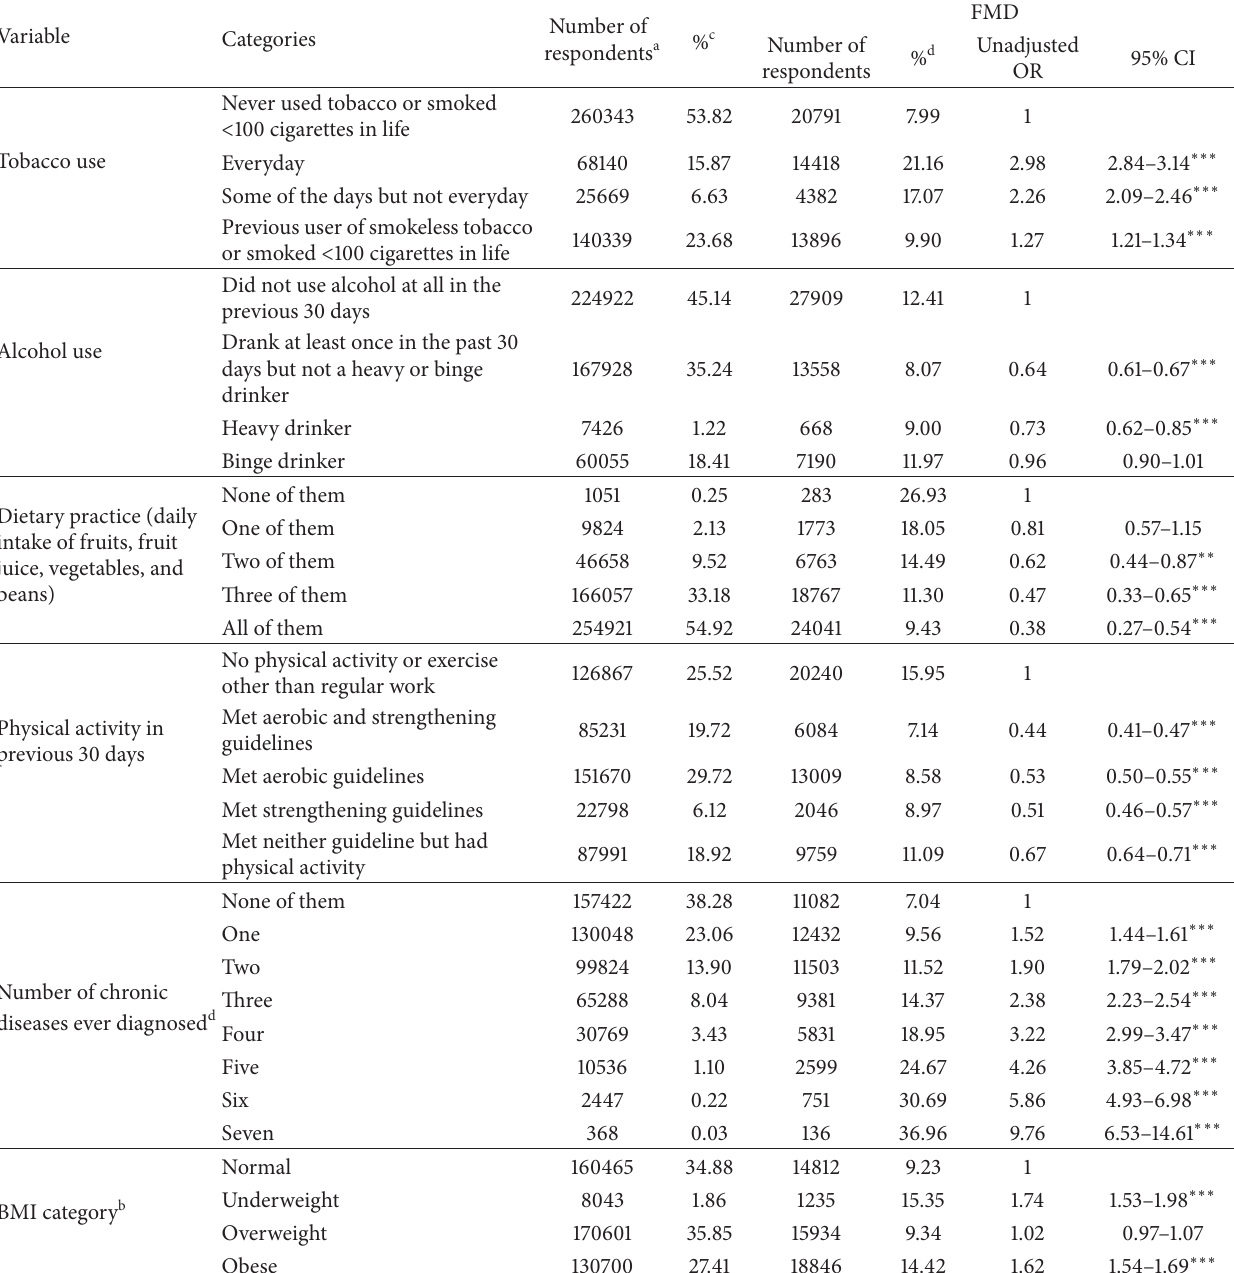
Table 3: Relationship of lifestyle factors, chronic disease, and BMI among adults in the United States, BRFSS 2011.